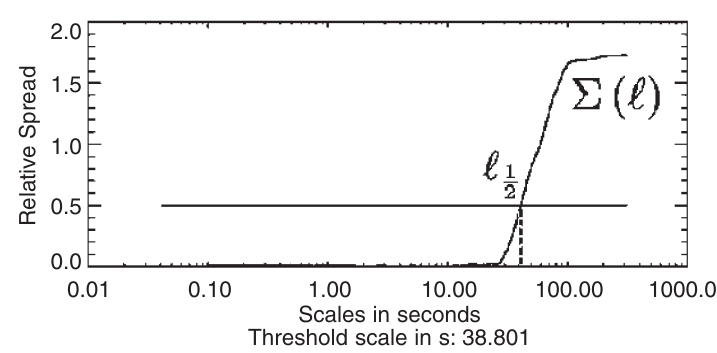
Fig. 15. The relative spread of the average continuous wavelet power as a function of time scale, among the amplitude scintillation signals detrended in three different ways (see Materassi et al .,